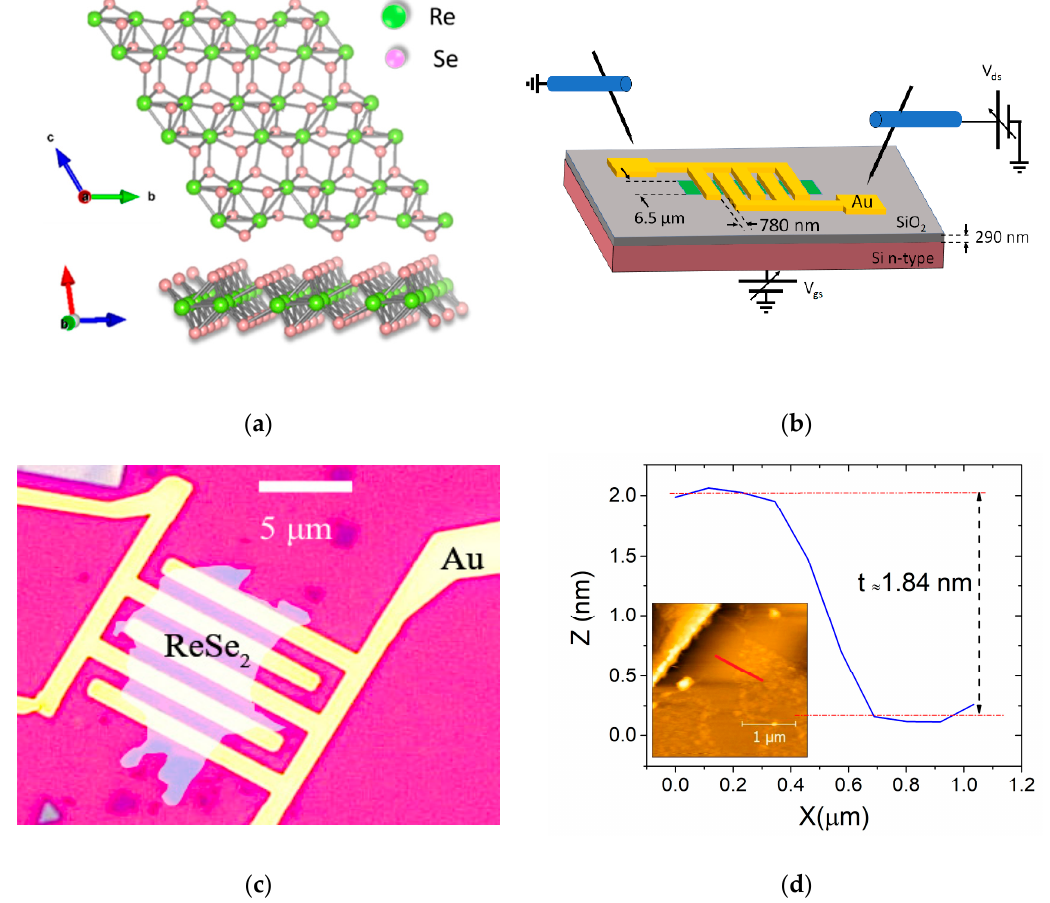
Figure 1. ( a ) Top view and side view of ReSe 2 atomic structure (the green and pink dots represent the Re and Se atoms, respectively); ( b ) schematic of the ReSe 2 back-gated FET with interdigitated source/drain leads. ( c ) Optical image of the ReSe 2 device with interdigitated Cr/Au leads. The flake is highlighted. ( d ) AFM vertical profile showing the flake thickness of 1.84 nm.